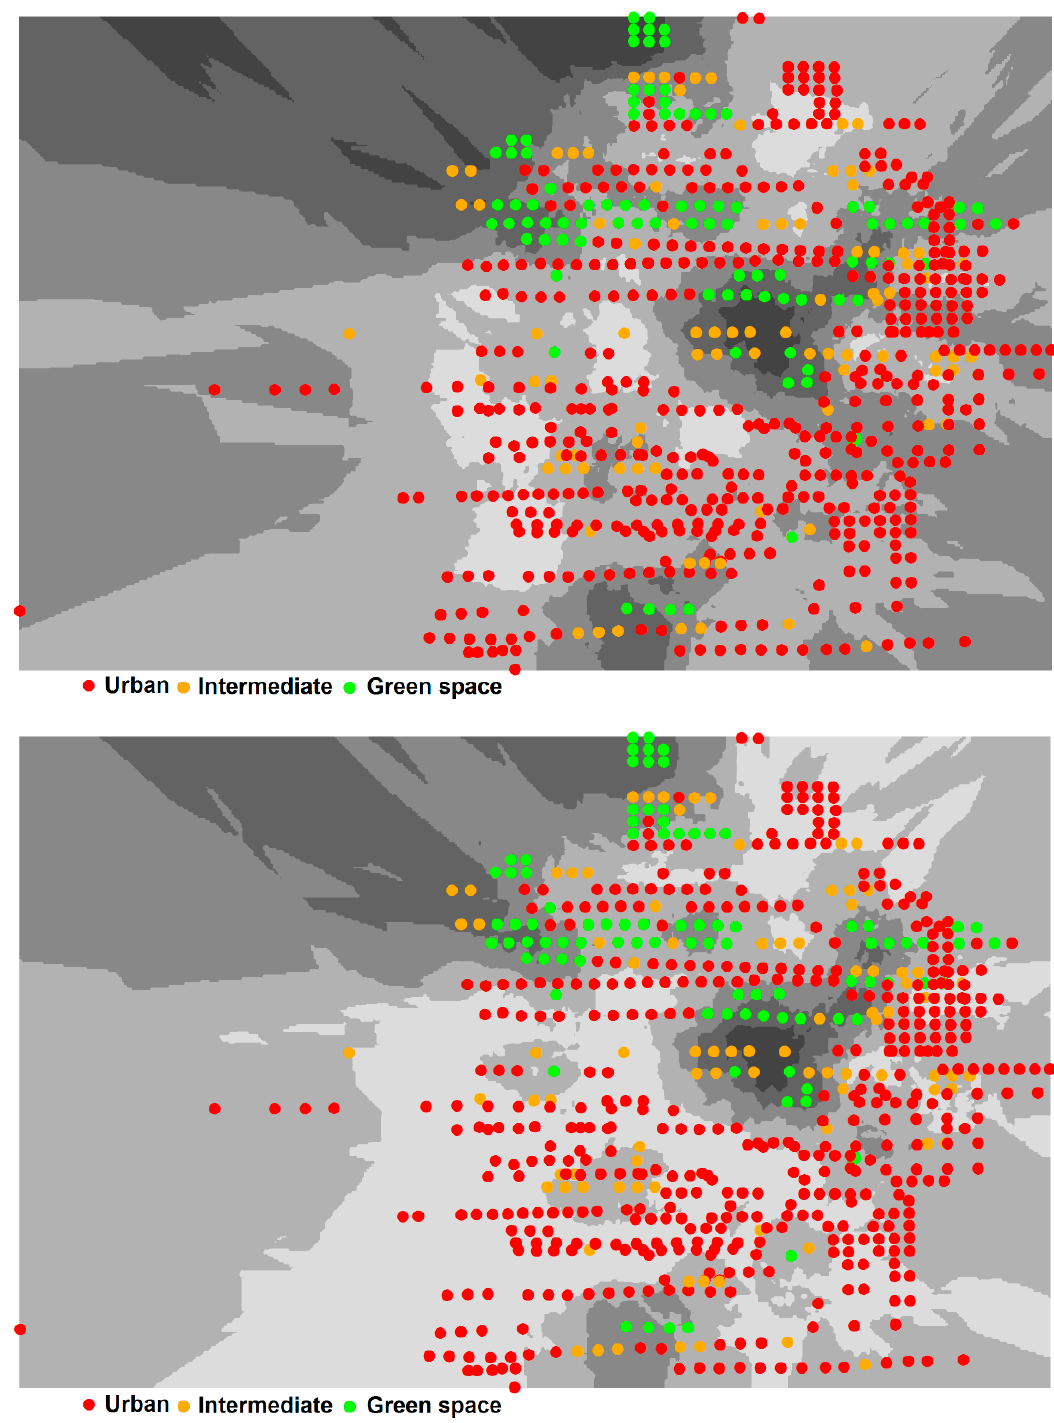
Figure 3. Interpolated spatial distribution of Shannon-Wiener’s informational entropy index ( top ) and species richness ( bottom ) in Annaba, Algeria. The darker shades correspond to higher values of the two indices, indicating higher biodiversity.